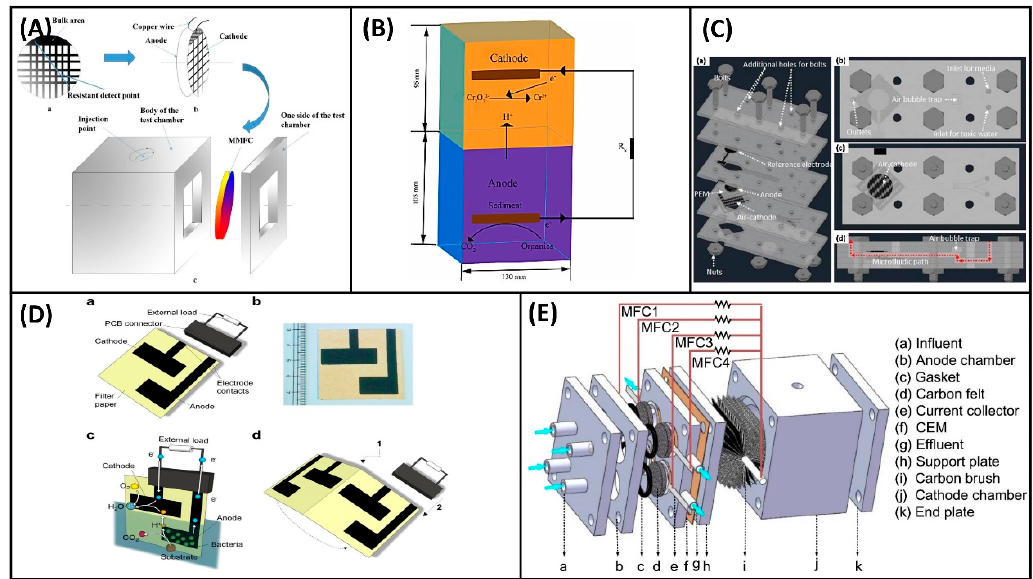
Figure 3. Photographs or schematics of MFC toxicity sensors: ( A ) membrane-based electrodes [77], ( B ) abiotic cathode sensing element [78], ( C ) miniature MFC with air bubble trap [79], ( D ) paper MFC [80], and ( E ) shared cathode [81].